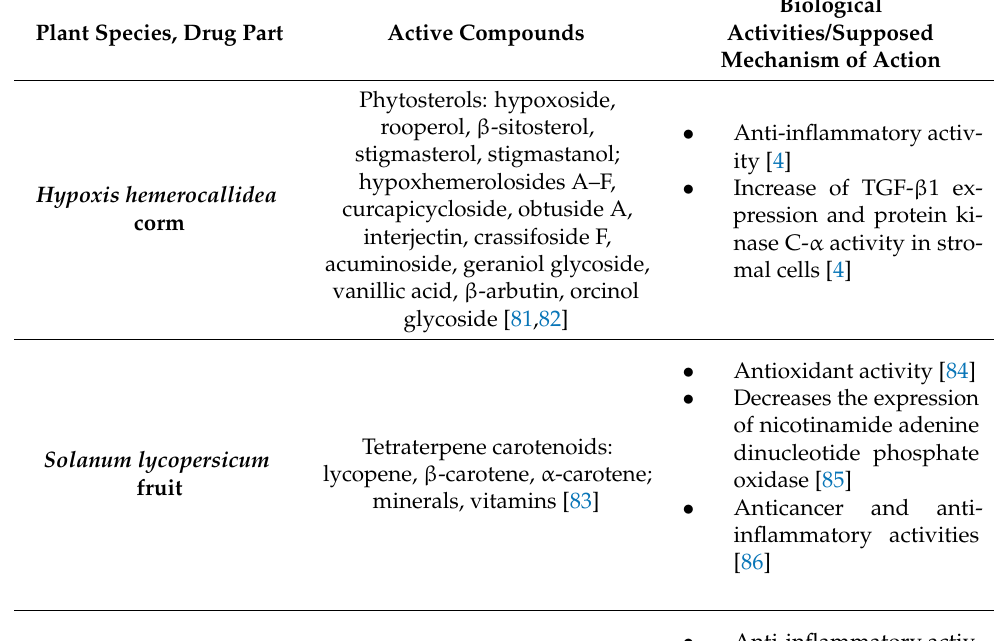
Plant Species, Drug